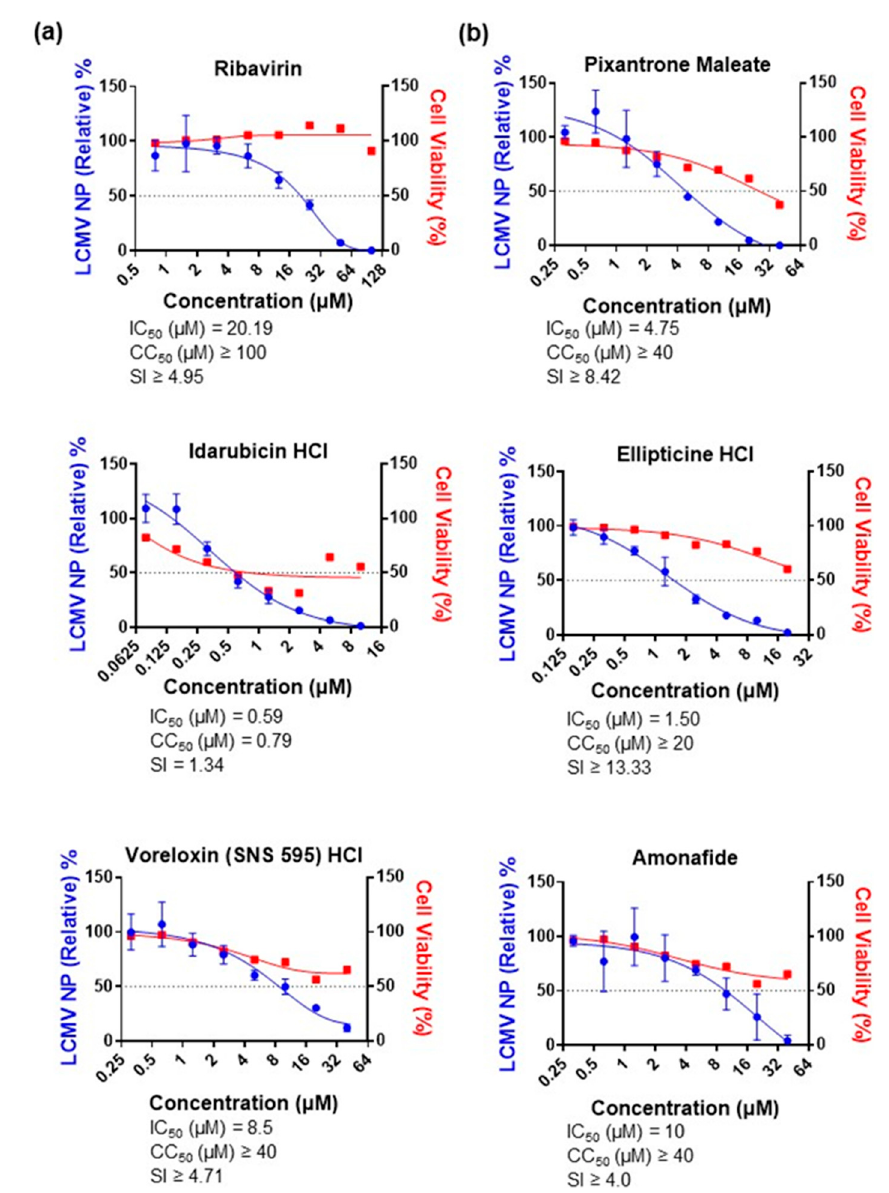
Figure 6. Inhibition of LCMV infection by ribavirin and topoisomerase II inhibitors. ( a ) Restriction of LCMV infection by ribavirin. A549 cells were seeded in 96-well plates and infected with LCMV (rLCMV.Arm) at an MOI of 0.1 at 24 h post-seeding. The virus was replaced with fresh medium at 1 h.p.i, and the cells were incubated with the compound at the indicated concentrations in triplicate for 24 h. The cells were then fixed, blocked, stained with anti-LCMV NP for 3 h, and later with secondary antibody for another 3 h before fluorescence was measured. ( b ) Restriction of LCMV infection by the topoisomerase II inhibitors pixantrone maleate, idarubicin hydrochloride, ellipticine hydrochloride, voreloxin (SNS 595) hydrochloride, and amonafide. LCMV infection, compound treatment, and assessment were performed as described in ( a ). Data are presented as means ± SD and are representative of two independent experiments. Values in untreated wells were set to 100%.